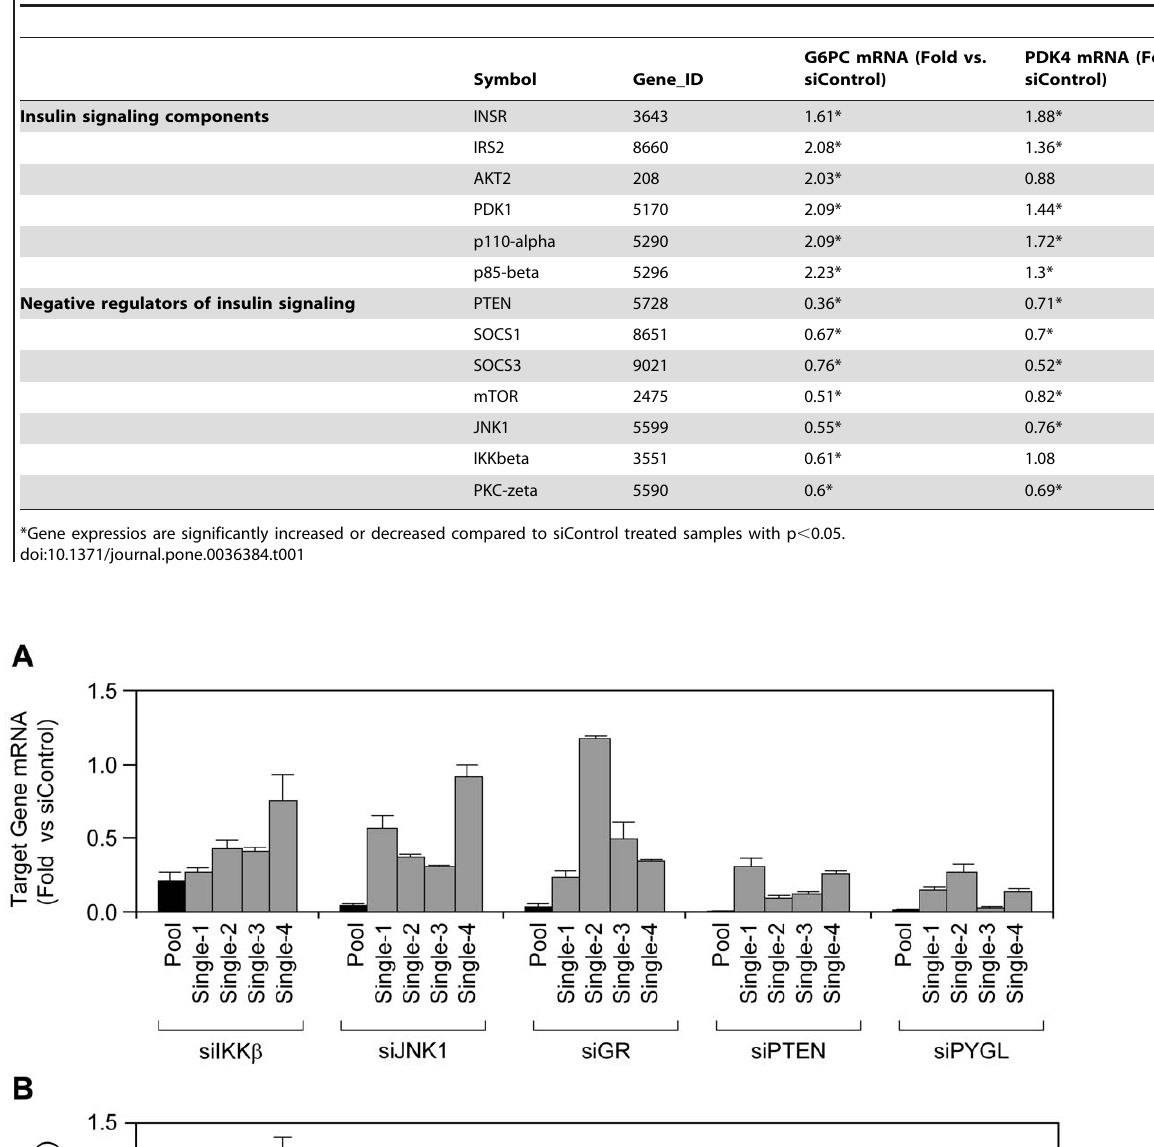
Table 1. Known mediators and inhibitors of insulin signal transduction identified in the HTG Screen.